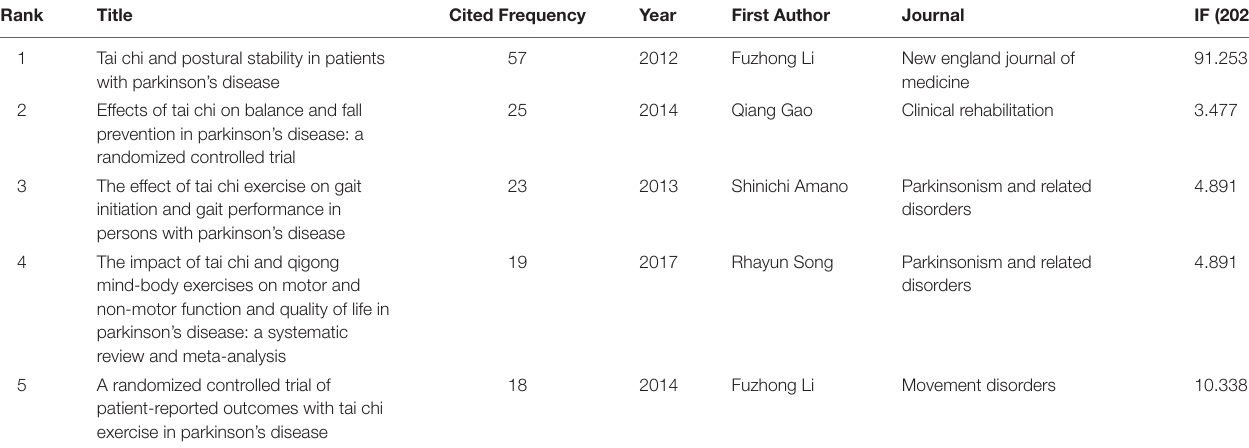
TABLE 6 | The top 5 cited